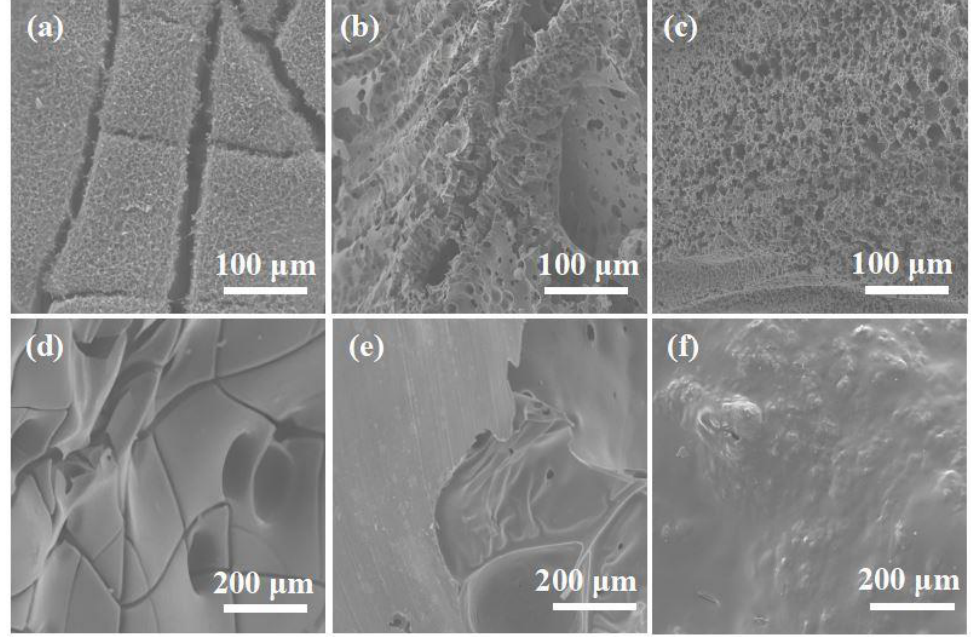
Figure 6. SEM images of external char layer: ( a ) EP; ( b ) EP/4 wt% CuPPA; ( c ) EP/4 wt% CuPPA- DOPO. SEM images of internal char layer: ( d ) EP; ( e ) EP/4 wt% CuPPA; ( f ) EP/4 wt% CuPPA-DOPO.